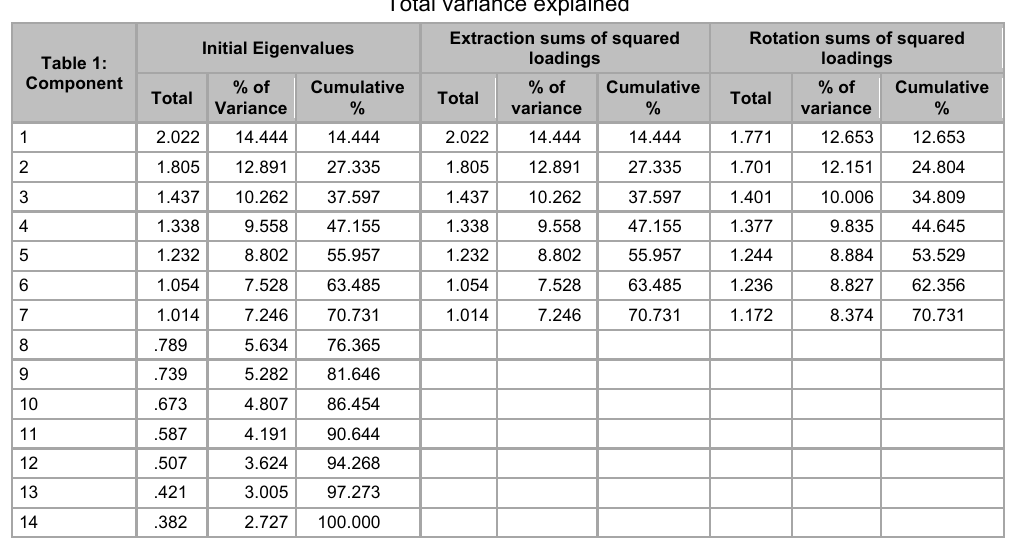
Initial Eigenvalues